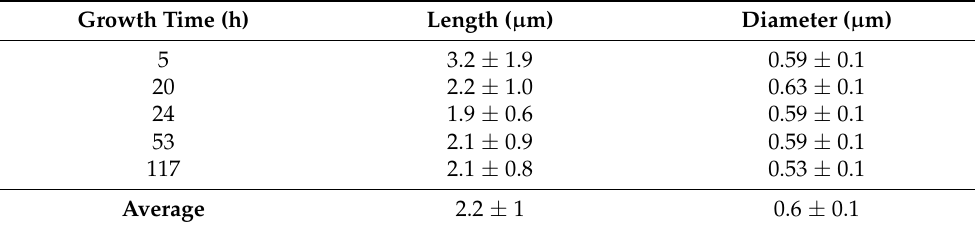
Table 2. Distributions of length and diameter of V. fischeri throughout the life cycle. Growth Time